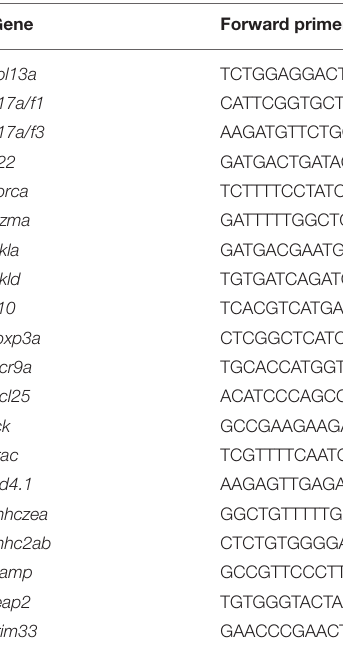
TABLE 1 | Sequences of primers used in